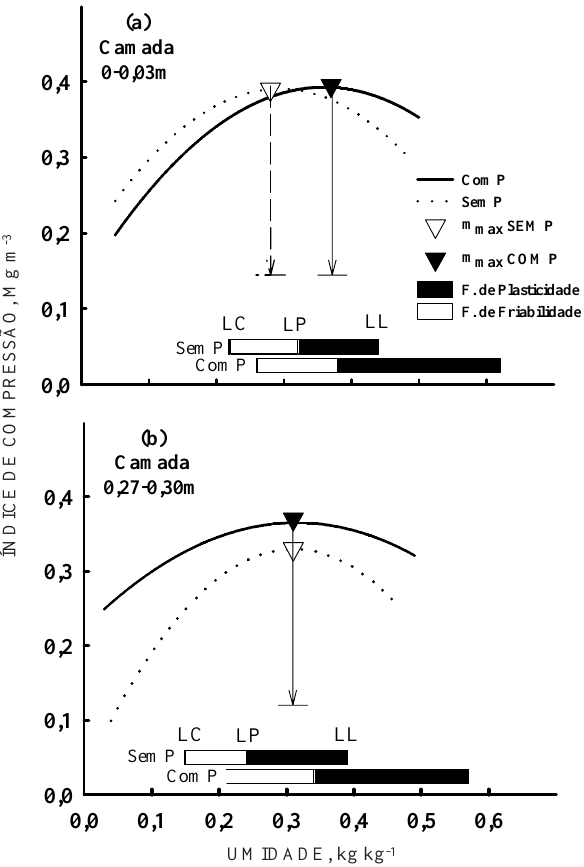
Figura 3. Índice de compressão (m) em função da umidade (U), nas camadas de 0-0,03 e 0,27- 0,30 m de um Latossolo Vermelho-Escuro, na condição com e sem